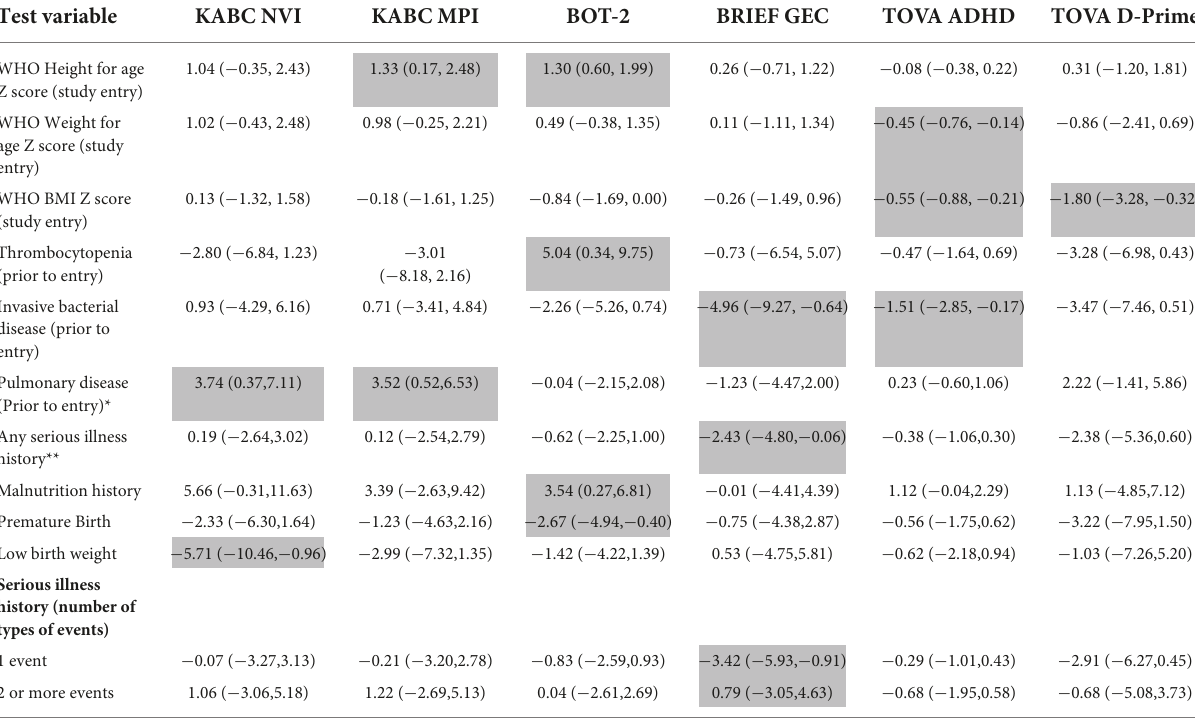
TABLE 3 Clinical factors associated with neuropsychological scores in